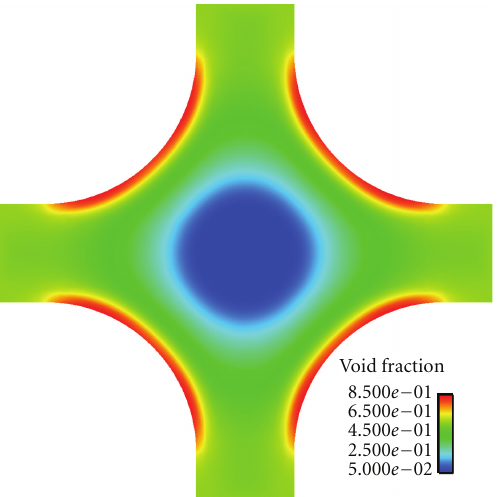
Figure 16: Void-fraction distribution at the measuring section for run 1.4325 with a fixed bubble diameter set to 0.3 mm.